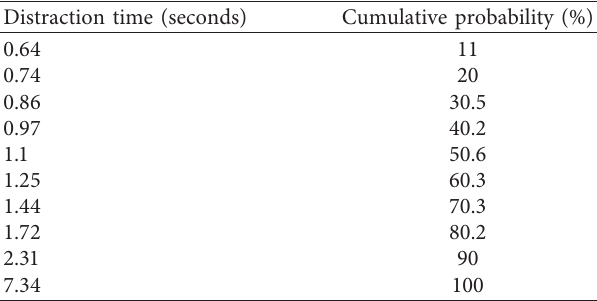
Table 1: The summary of calculated values for distraction time of the random sample.